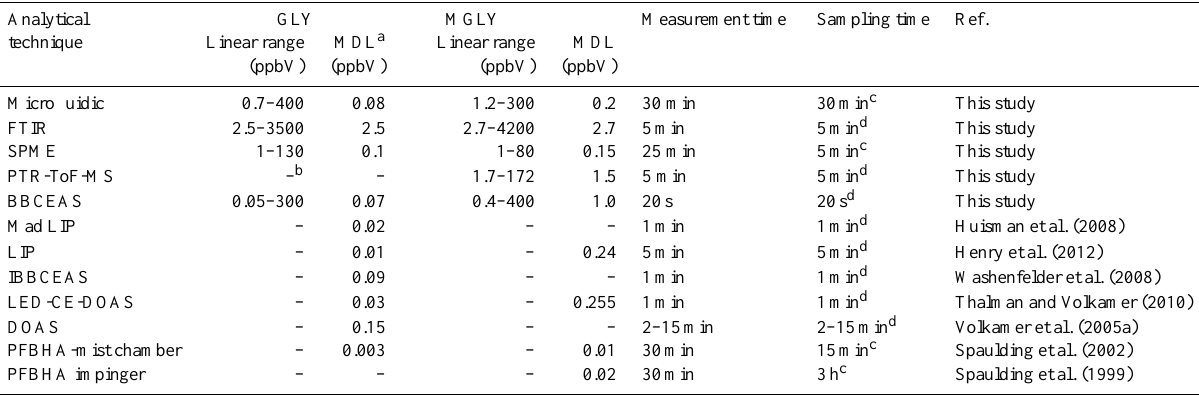
Table 2. Comparison between the microfluidic derivatisation technique and other methods including linear range and method detection limit (MDL is calculated on 3 times standard deviation of the S/N of the blank samples).